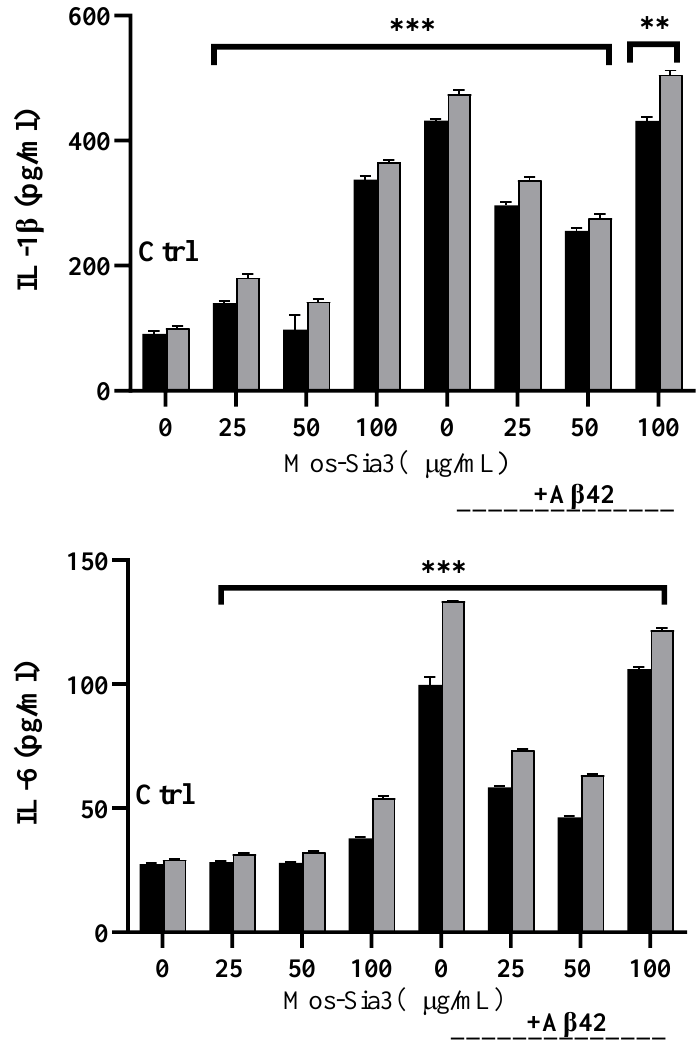
Figure 7. Effects of MOS-Sia3 on cytokine secretion in BV-2 cells induced by A β 42. Captions: Black bar, 24 h of culture; gray bar: 48 h of culture. Data are shown as the mean ± SD of triplicates with good reproducibility. SD is represented as error bars. Statistically significant differences are indicated: ** for p ≤ 0.01, and *** for p ≤